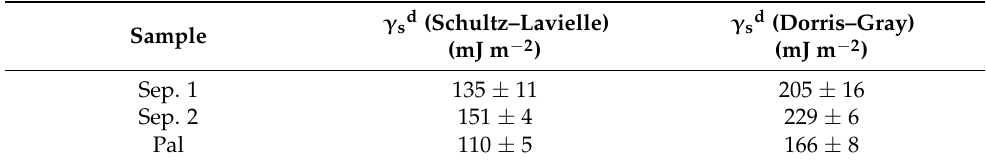
Table 1. Dispersive component of the surface free energy of sepiolite and palygorskite samples at 240 ◦